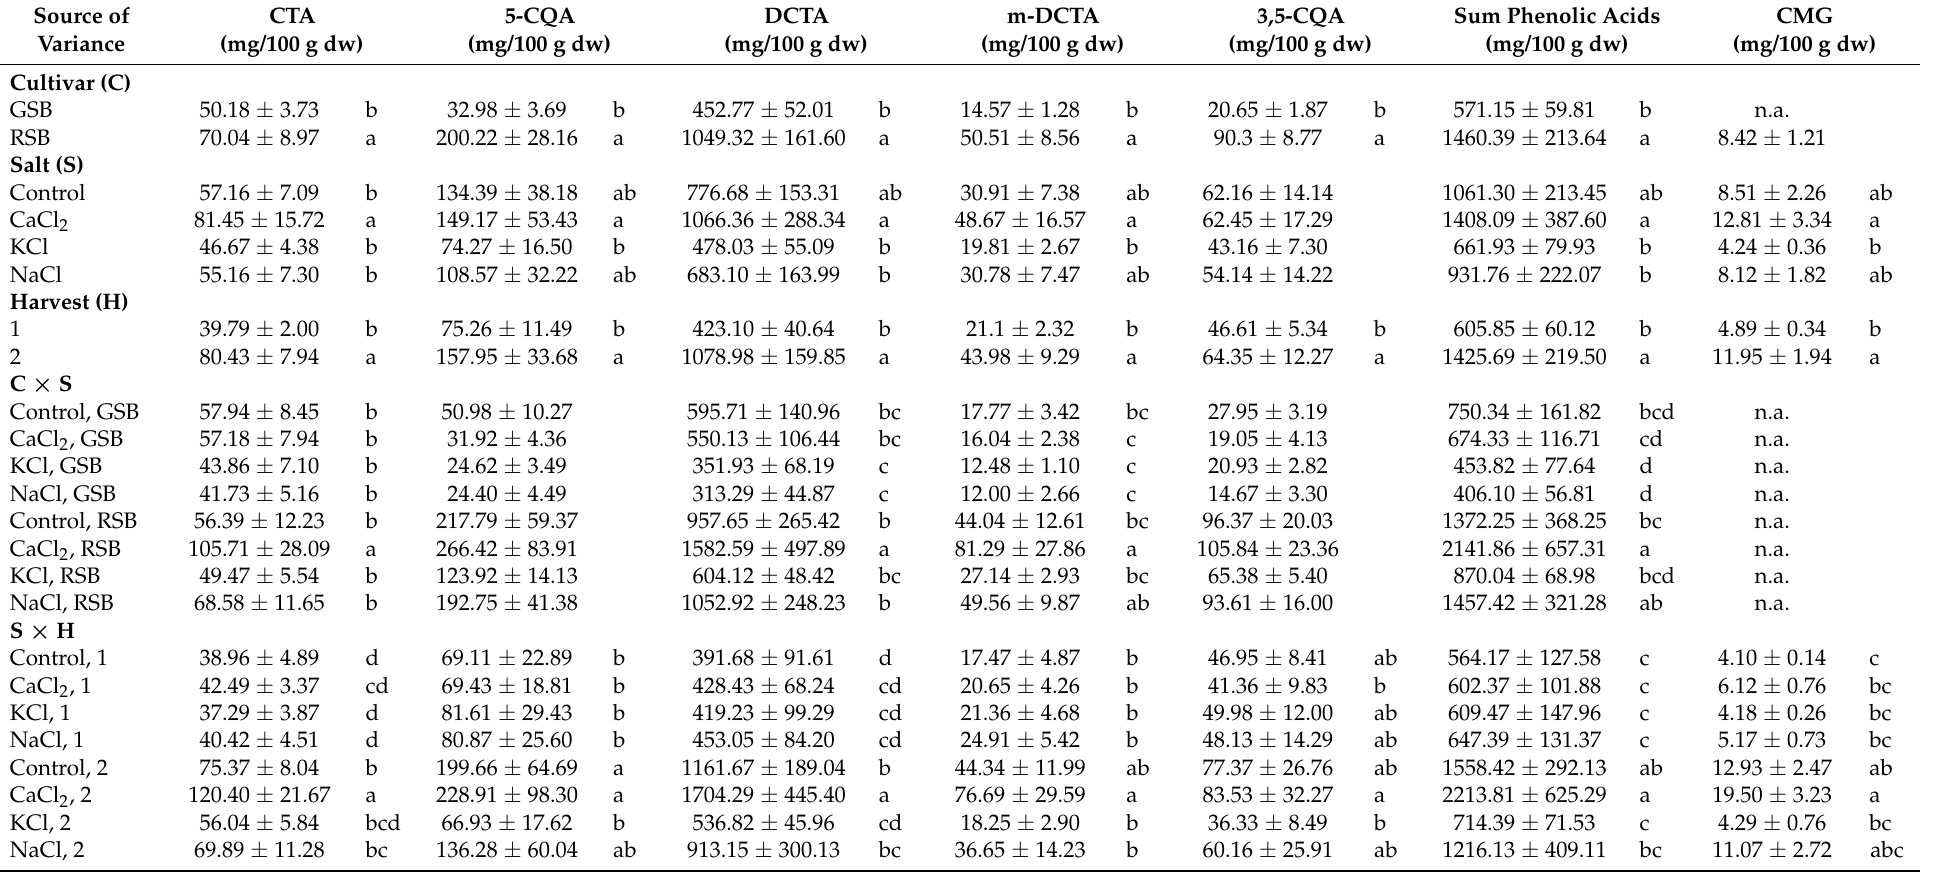
Table 2. Effect of the experimental factors (Cultivar: C, Harvest: H, Salt: S) on the polyphenols and anthocyanins of the two baby lettuce varieties, GSB and RSB. CTA: Caffeoyltartaric acid: CTA; 5-CQA: 5- O -caffeoylquinic acid, aka chlorogenic acid; CMA: caffeoylmalic acid; DCTA: di- O -caffeoyltartaric acid, aka cichoric acid; m-DCTA: meso-di- O